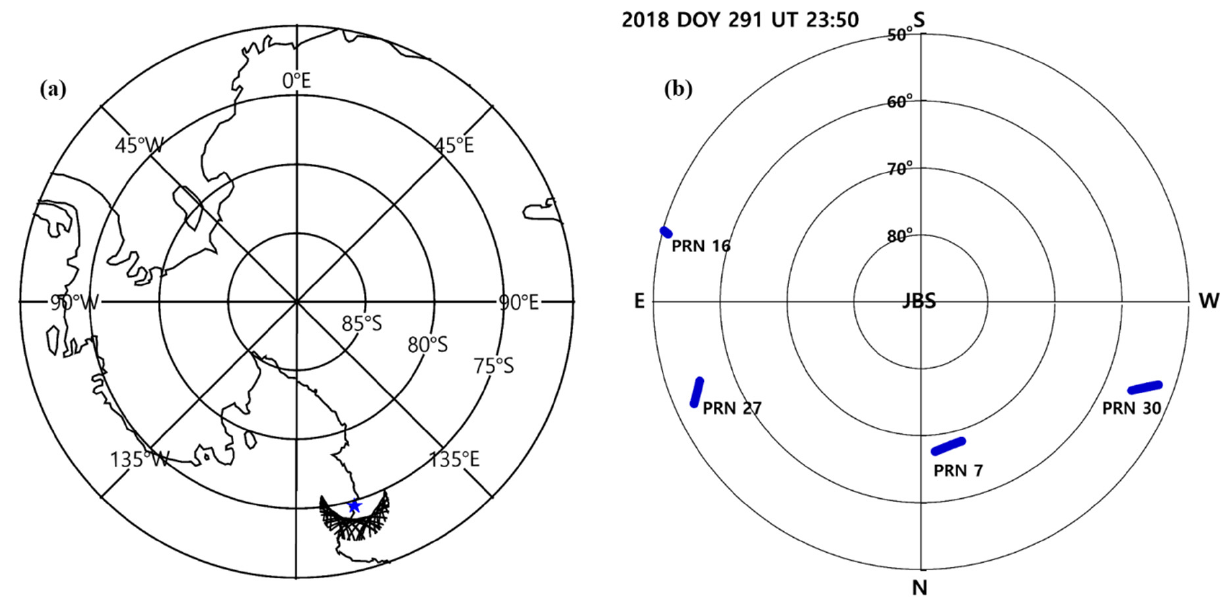
Figure 1. Spatial distribution of the ionospheric pierce points (IPPs) (black dots) for the TEC measure- ments over the JBS (blue star) from the GPS satellites with the elevation angles greater than 50 ◦ for DOY 291, 2018 ( a ) and four GPS satellite paths for 10 min from 23:50 to 23:59 UT in azimuth-elevation coordinate ( b ) over JBS.